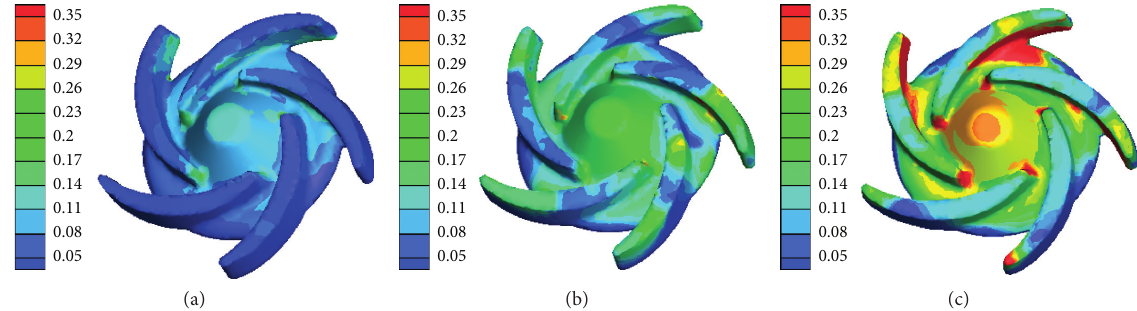
Figure 10: Cloud diagram of solid-phase volume distribution of impeller of different concentrations ( d � 0.1mm): (a) C (b) C v � 20%, and (c) C v � 30%.